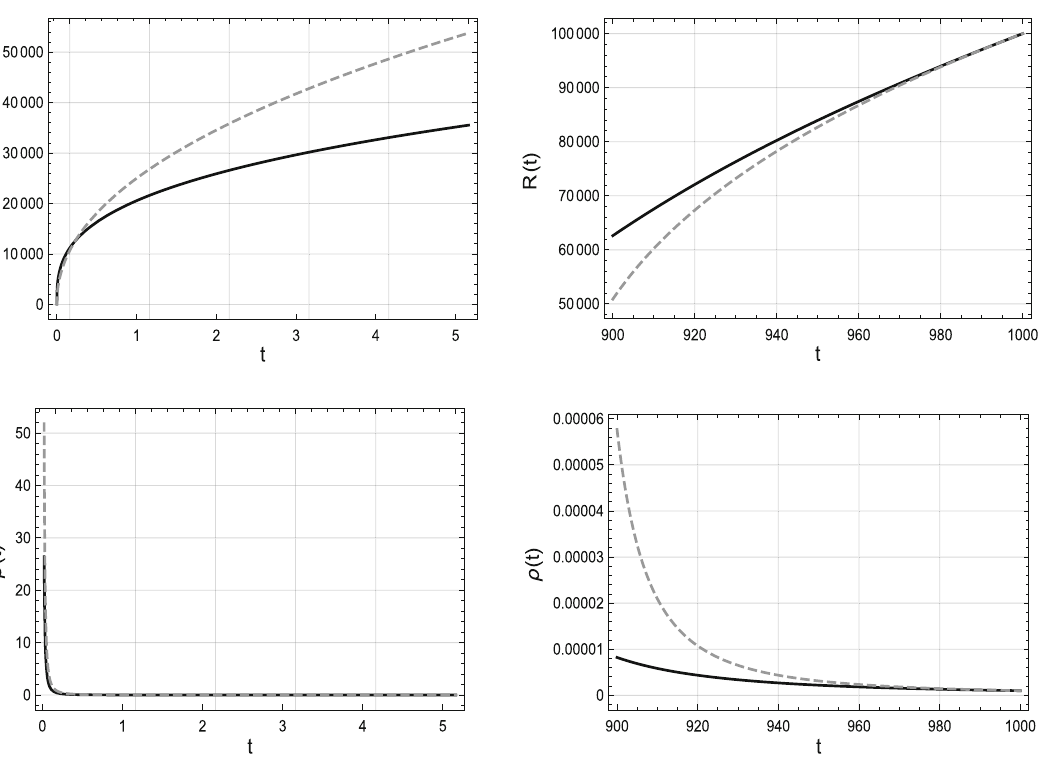
Fig. 1 ( Left ) Numerical integration of the viscous isotropic model ( continuous line ). The power-law approximation, given by the dashed line , is shown to give reliable predictions of the dynamics of the Uni- verse near the singularity. ( Right ) Far from the singularity evolution